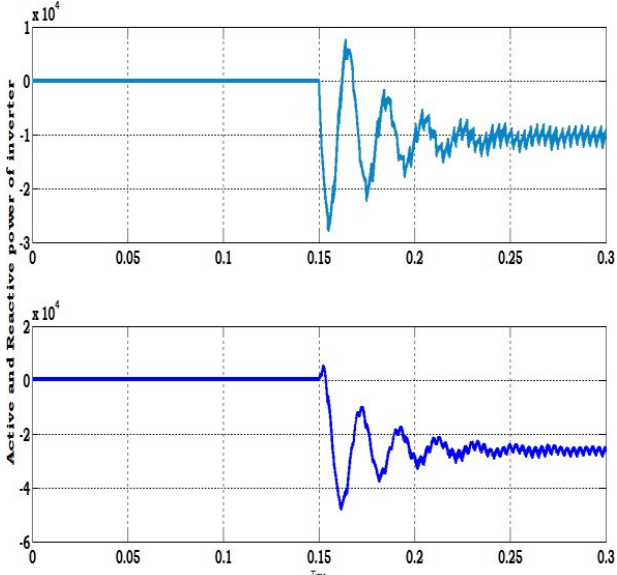
Figure 11. Waveform of Load Current